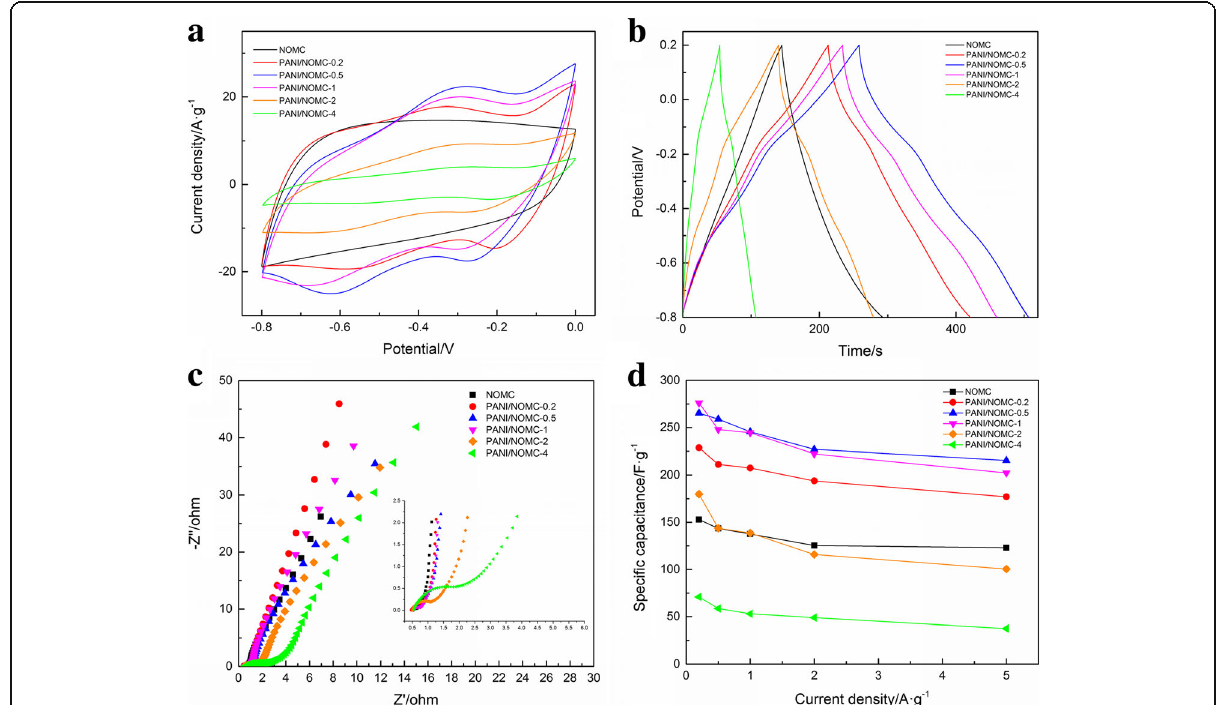
Fig. 4 CV curves of NOMC and PANI/NOMC- x at a scan rate of 0.1 V/s ( a ) Galvanostatic charge/discharge curves of NOMC and PANI/NOMC- x at a current density of 1 A/g ( b ). Nyquist plots of NOMC and PANI/NOMC- x ( c ). Specific capacitance of NOMC and PANI/NOMC- x electrodes with different current densities ( d ). 0.6 M KOH was used as the electrolyte for all